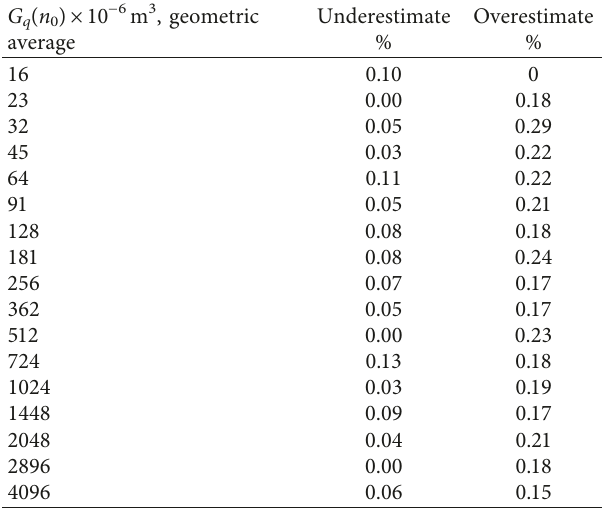
Figure 11: The characteristics of modified ADV values compare with the original. Table 3: Error times of road roughness classification at different roughness sections in